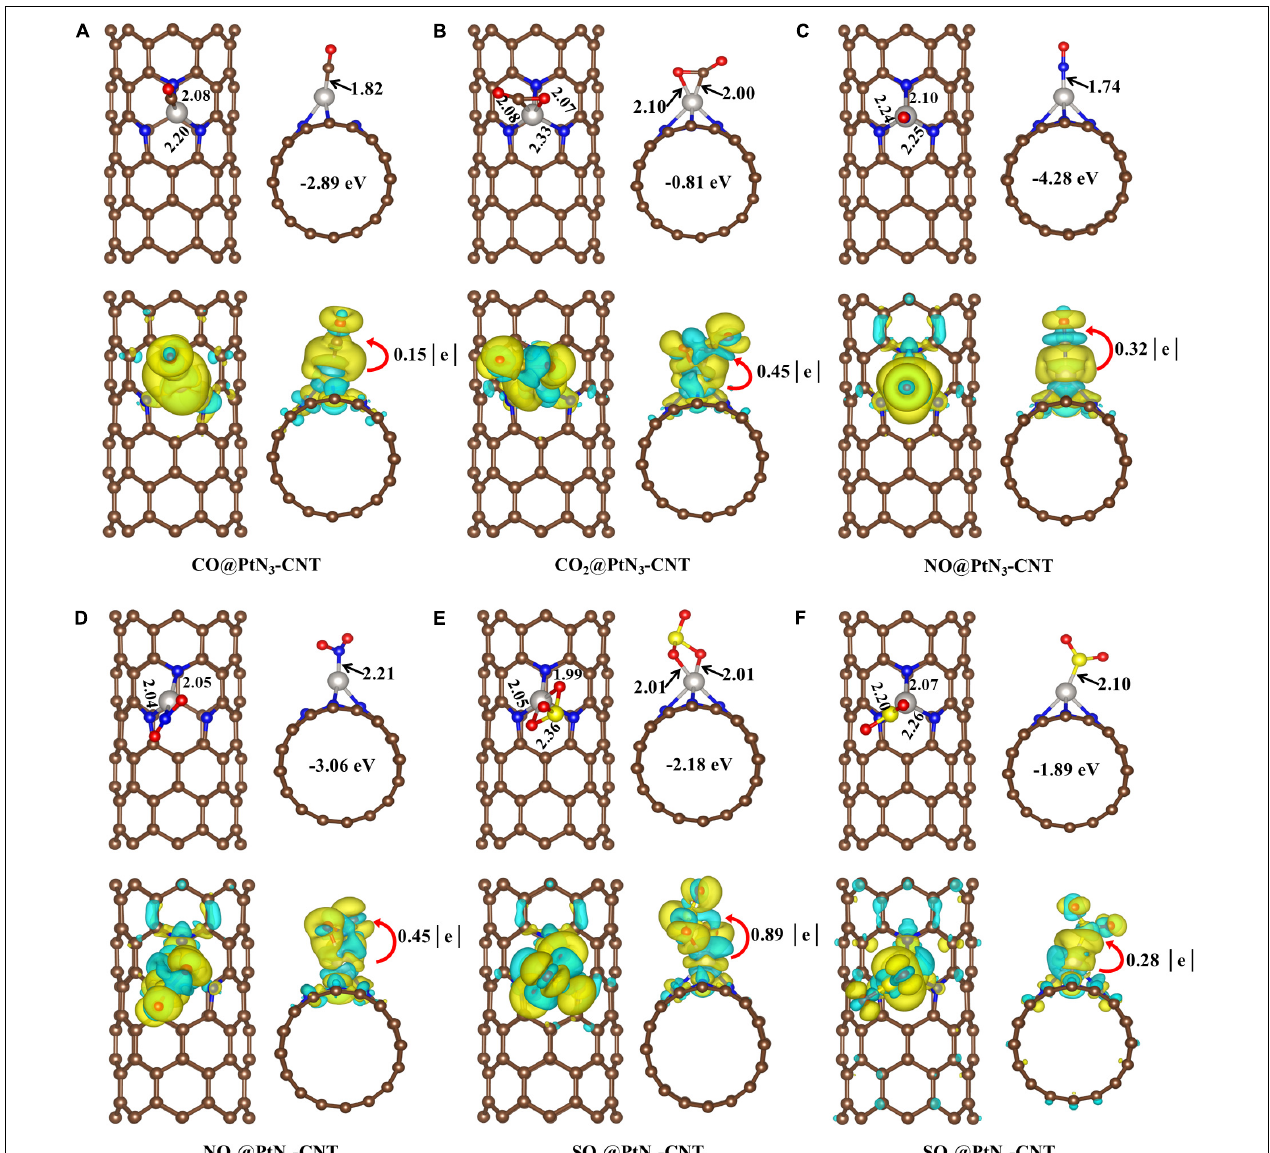
FIGURE 2 | Adsorption structures and deformation charge distribution of (A) CO@PtN 3 -CNT system; (B) CO 2 @PtN 3 -CNT system; (C) NO@PtN 3 -CNT system; (D) NO 2 @PtN 3 -CNT system; (E) SO 3 @PtN 3 -CNT system; and (F) SO 2 @PtN 3 -CNT system. In the middle of the side views are the adsorption energies of the gas molecules. Yellow and red balls represent S and O atoms, respectively. The yellow area and cyan area represent the accumulation and consumption of electrons,